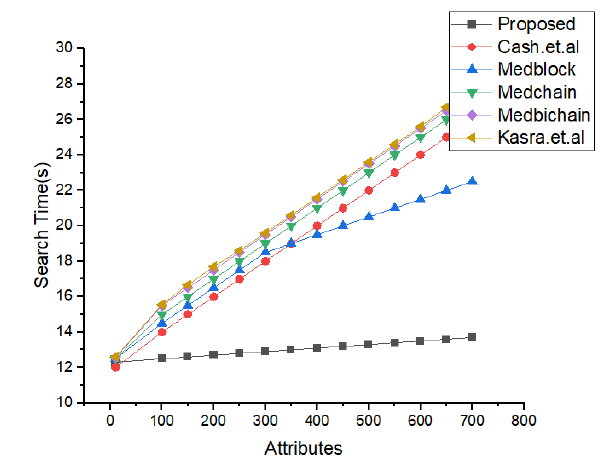
Figure 19. Comparative Analysis of concurrent requests for the proposed policies.